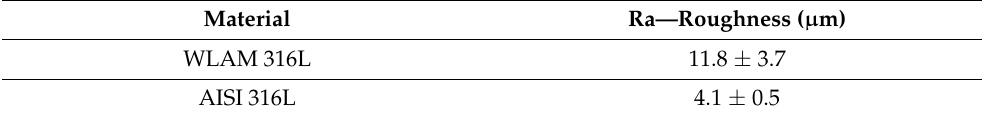
Figure 1. Cross-section views of WLAM 316L samples ( a ) high magnification (×50) ( b ) low magni- fication (×5). Table 1. Surface roughness of WLAM 316L samples compared with the counterpart AISI 316L alloy.